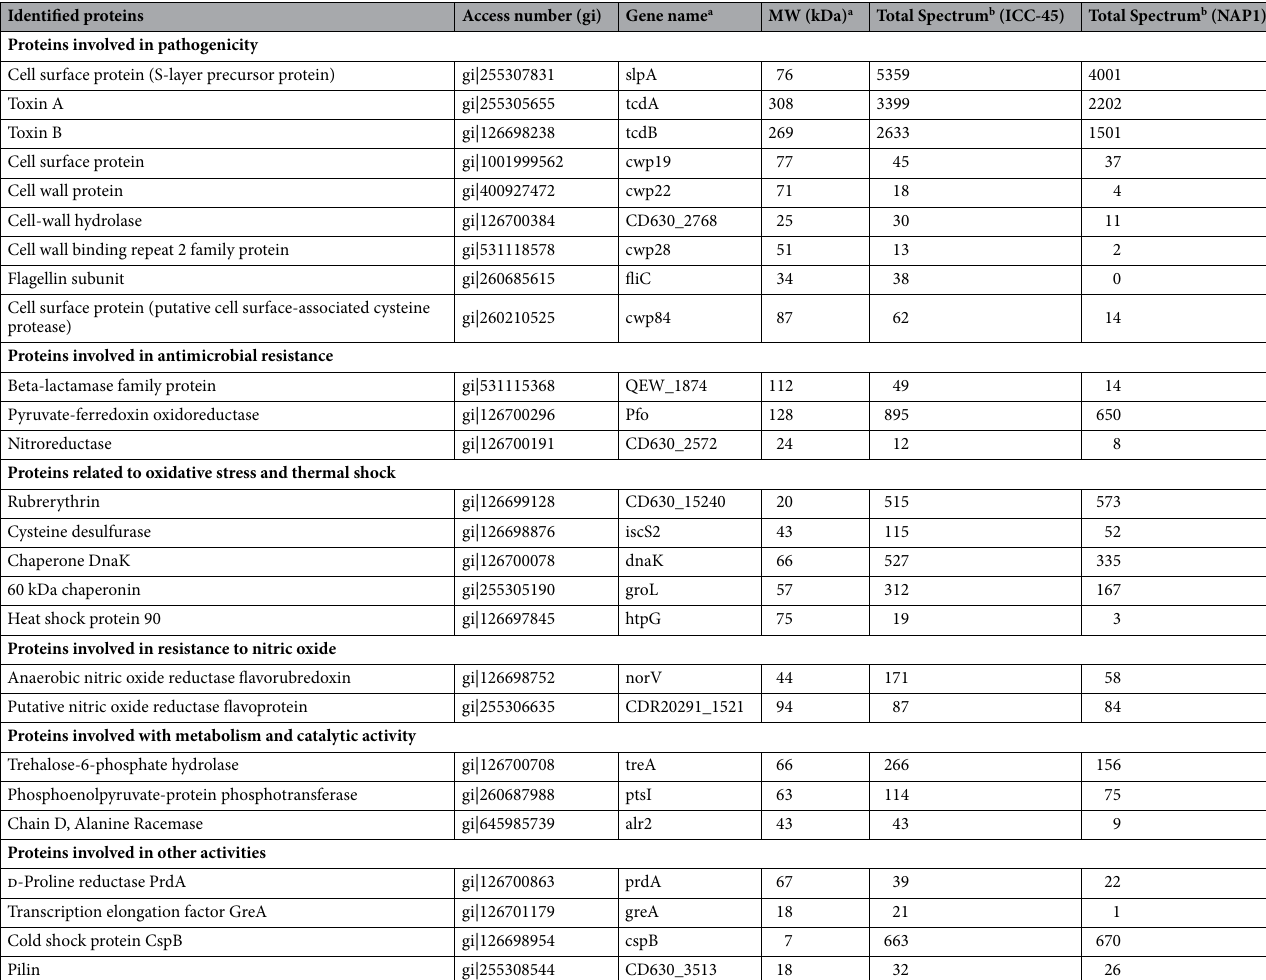
Table 2. Relative amount of proteins secreted by Clostridioides difficile strains ICC-45 and NAP1/027 (LIBA5756). a Functional annotations were taken from the Swiss protein database (https:// www. unipr ot. org). b Concentration based on the amount of total spectrum found using Scaffold (v. 4.8.6.0; Proteome Software Inc., Portland, Oregon,